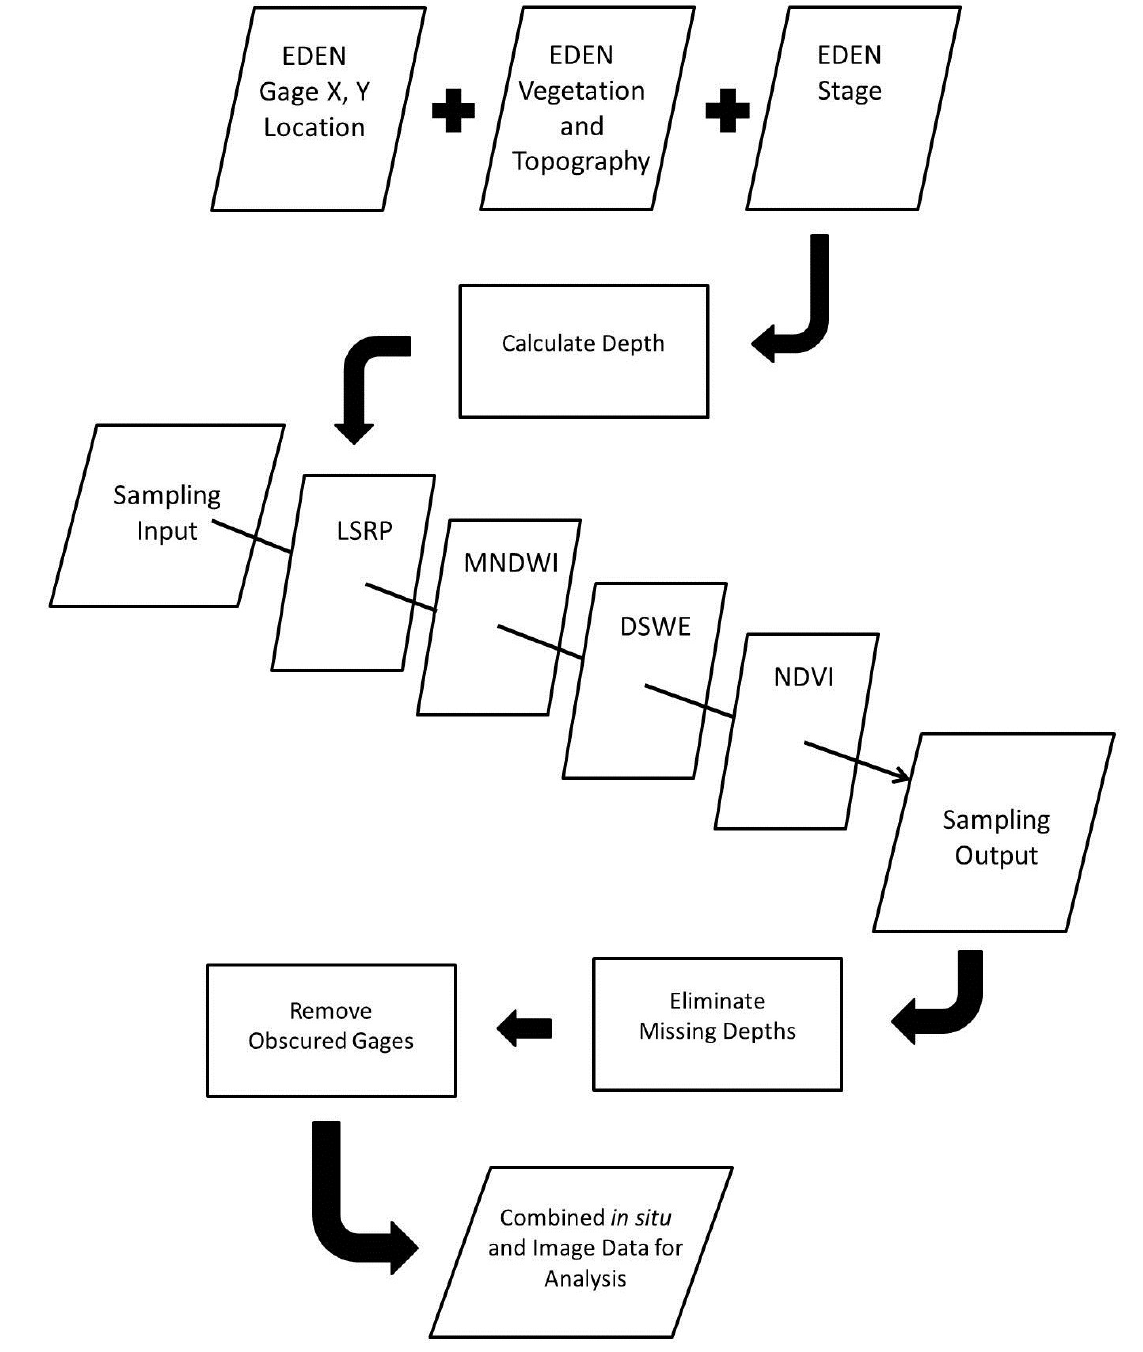
Figure 5. Procedure used to combine publicly available EDEN gage and ancillary data and associate them with values sampled from publicly available Landsat Land Surface Reflectance